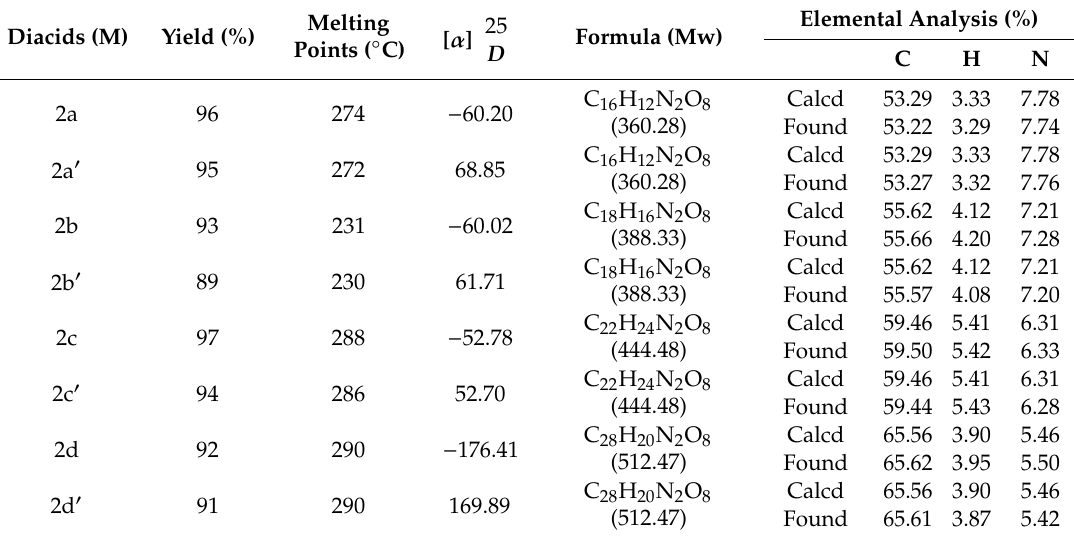
Table 1. Yields and physical properties of the diacid monomers (2a–2d ′ ). Diacids